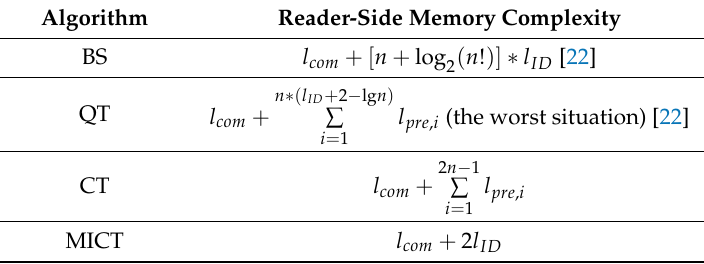
Table 8. Comparison of the reader-side memory complexity.